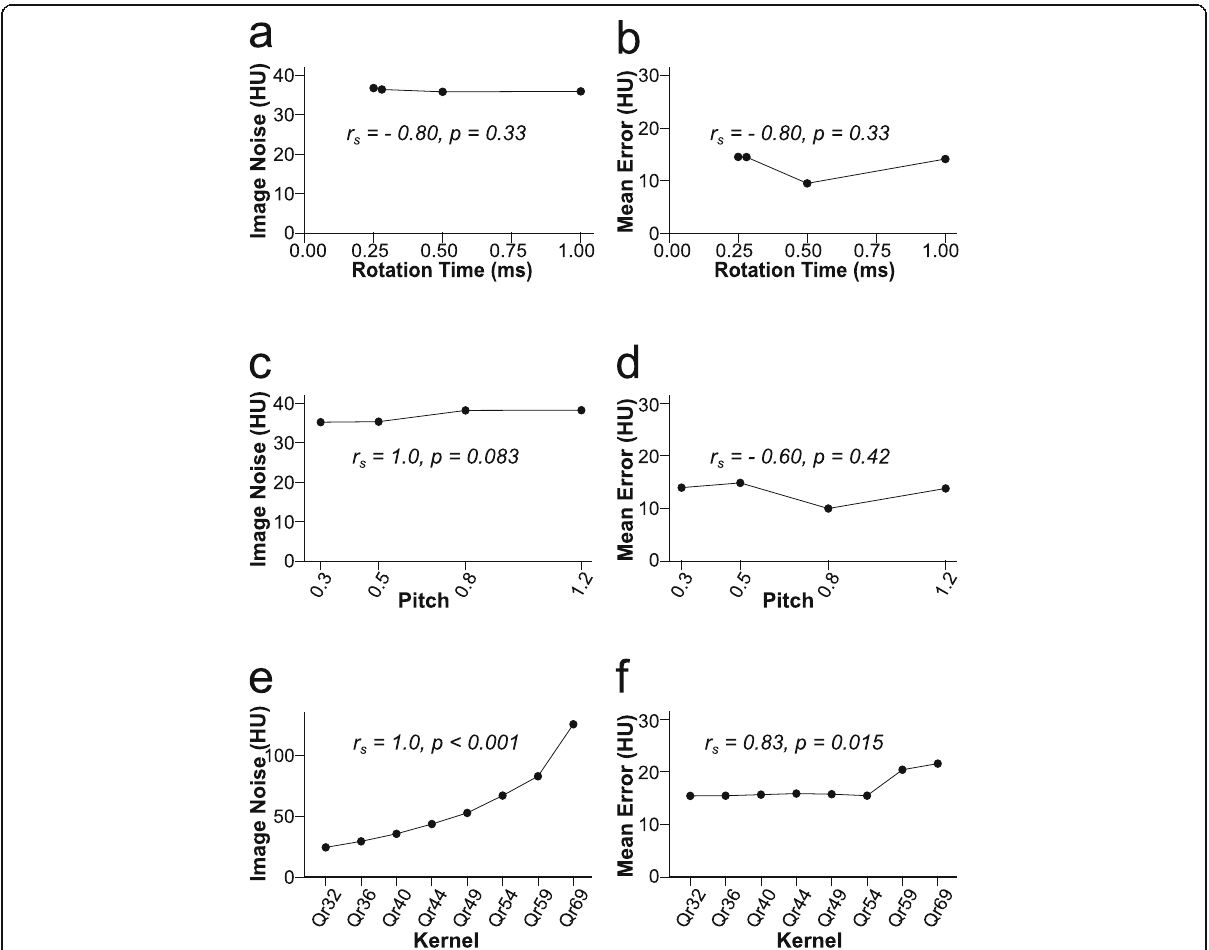
Fig. 5 Influence of rotation time, pitch and reconstruction kernel on accuracy and image noise. Shown is the influence of rotation time, pitch, and the reconstruction kernel on image noise ( a , c , e ) and accuracy ( b , d , f ) of virtual non-calcium images. Only the reconstruction kernel significantly correlated with accuracy and image noise. Reconstruction kernels (Qr32 through Qr69) in ( e , f ) are sorted with increasing kernel sharpness from left to right; HU Hounsfield units; r s Spearman rank correlation